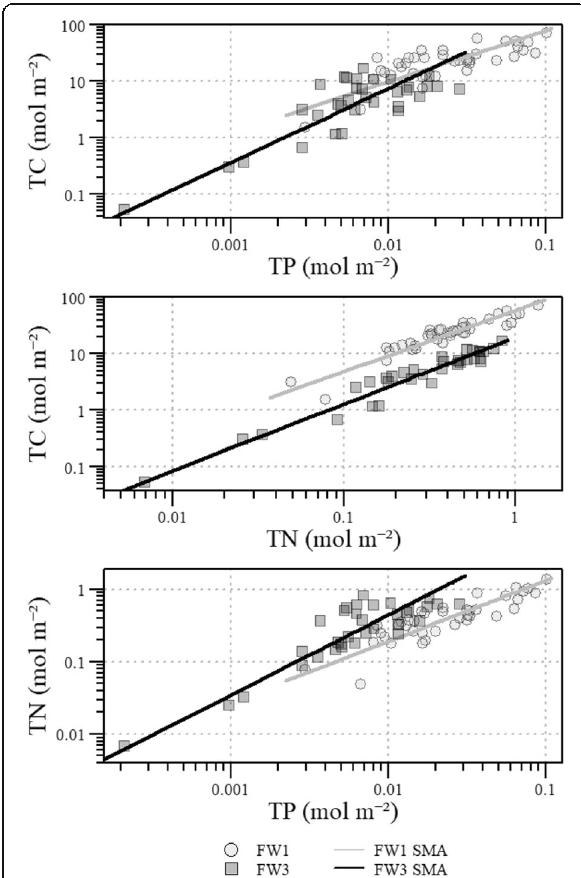
Fig. 7 Stoichiometric relationships between total carbon (TC), total phosphorus (TP), and total nitrogen (TN) in vegetation ecosystem compartment for Stormwater Treatment Area 2, flow-ways (FWs) 1 and 3. Inflow, mid, outflow, and overall standardized major axis (SMA) regressions indicated by lines through the data. Values can be converted to mass of nutrient per mass of soil (i.e., milligram per kilogram) concentration by multiplying each value by its respective conversion factor (C = 12.01; N = 14.00; P =